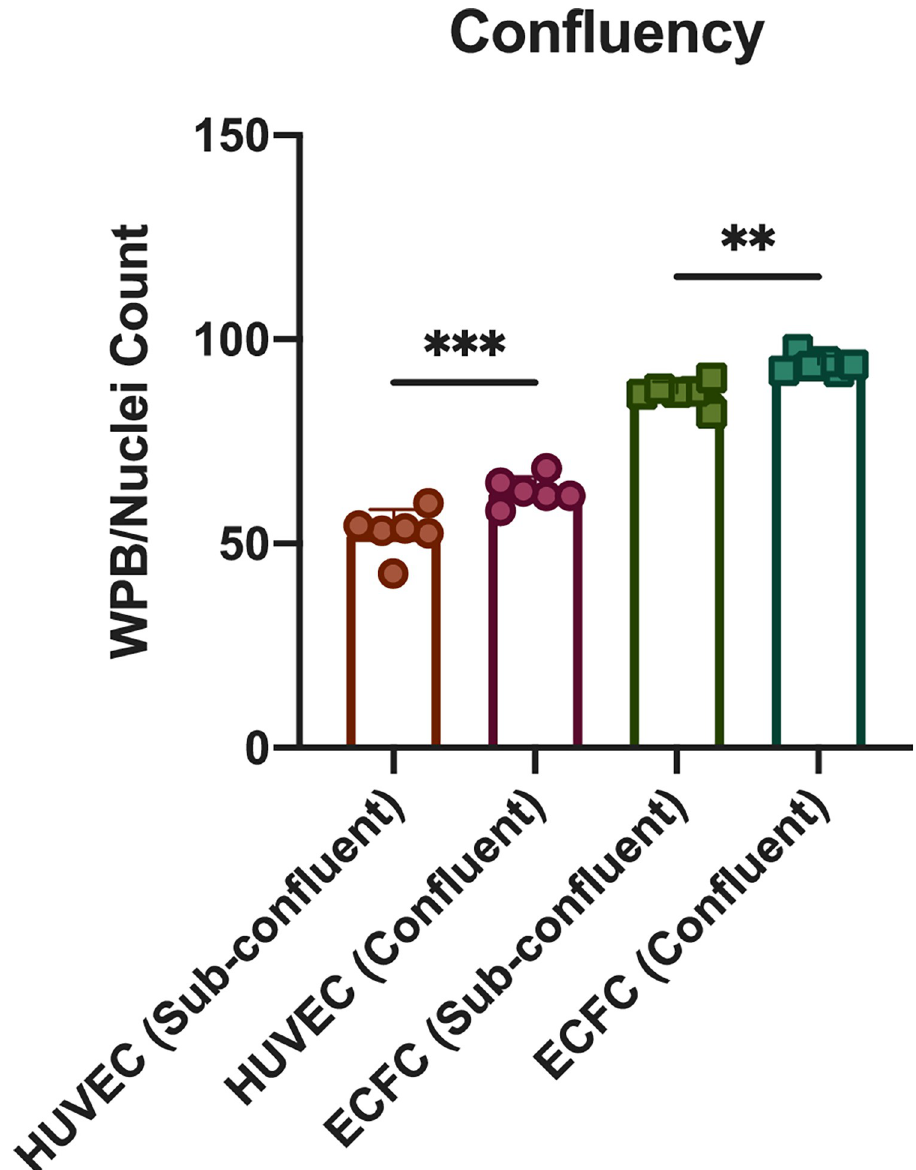
Fig 3. Assessment of WPB/Nuclei count in sub-confluent versus confluent cultures. WPB/Nuclei count is assessed in both sub-confluent and confluent cell cultures. Confluence was determined to be 51 cells/field for HUVECs and 75 cells/field for ECFCs as established in methods. A 1-way ANOVA was performed to analyze the WPB/Nuclei count of HUVECs and ECFCs in sub-confluent v. confluent cell cultures, �� p < 0.0021, ��� p < 0.0002 (n = 3).